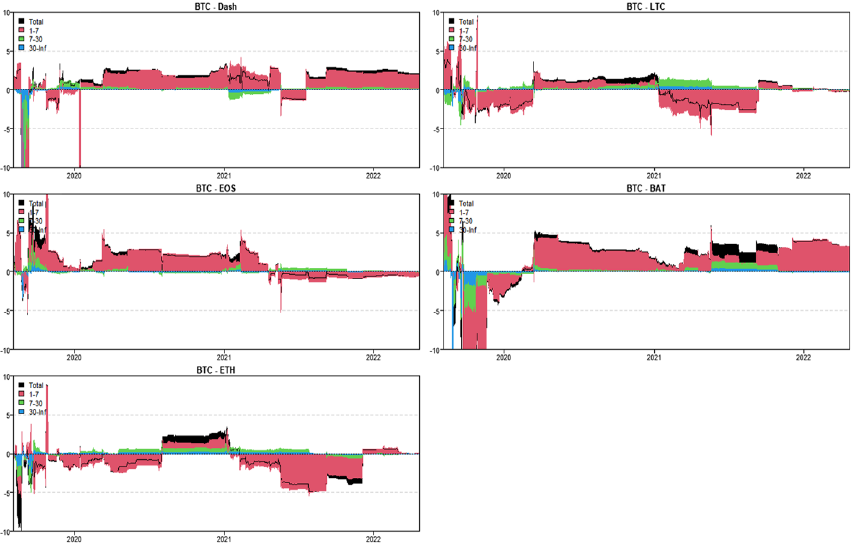
Fig. 19 Dynamic net-pairwise connectedness—signed jump variation